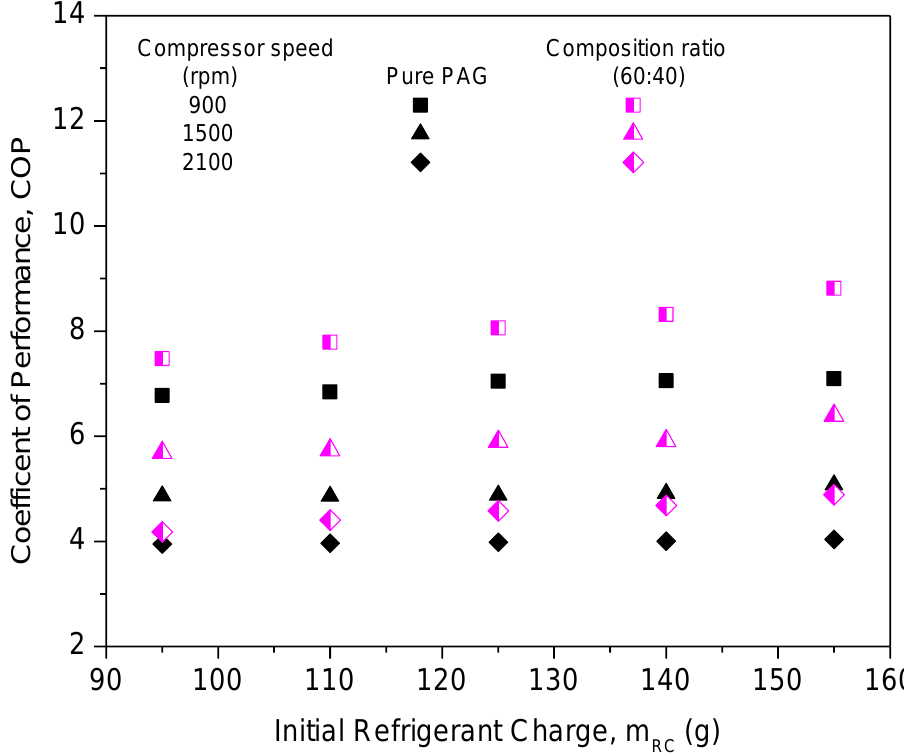
Figure 13. Compressor work of hybrid nanolubricants at the optimum 60:40 composition ratio.